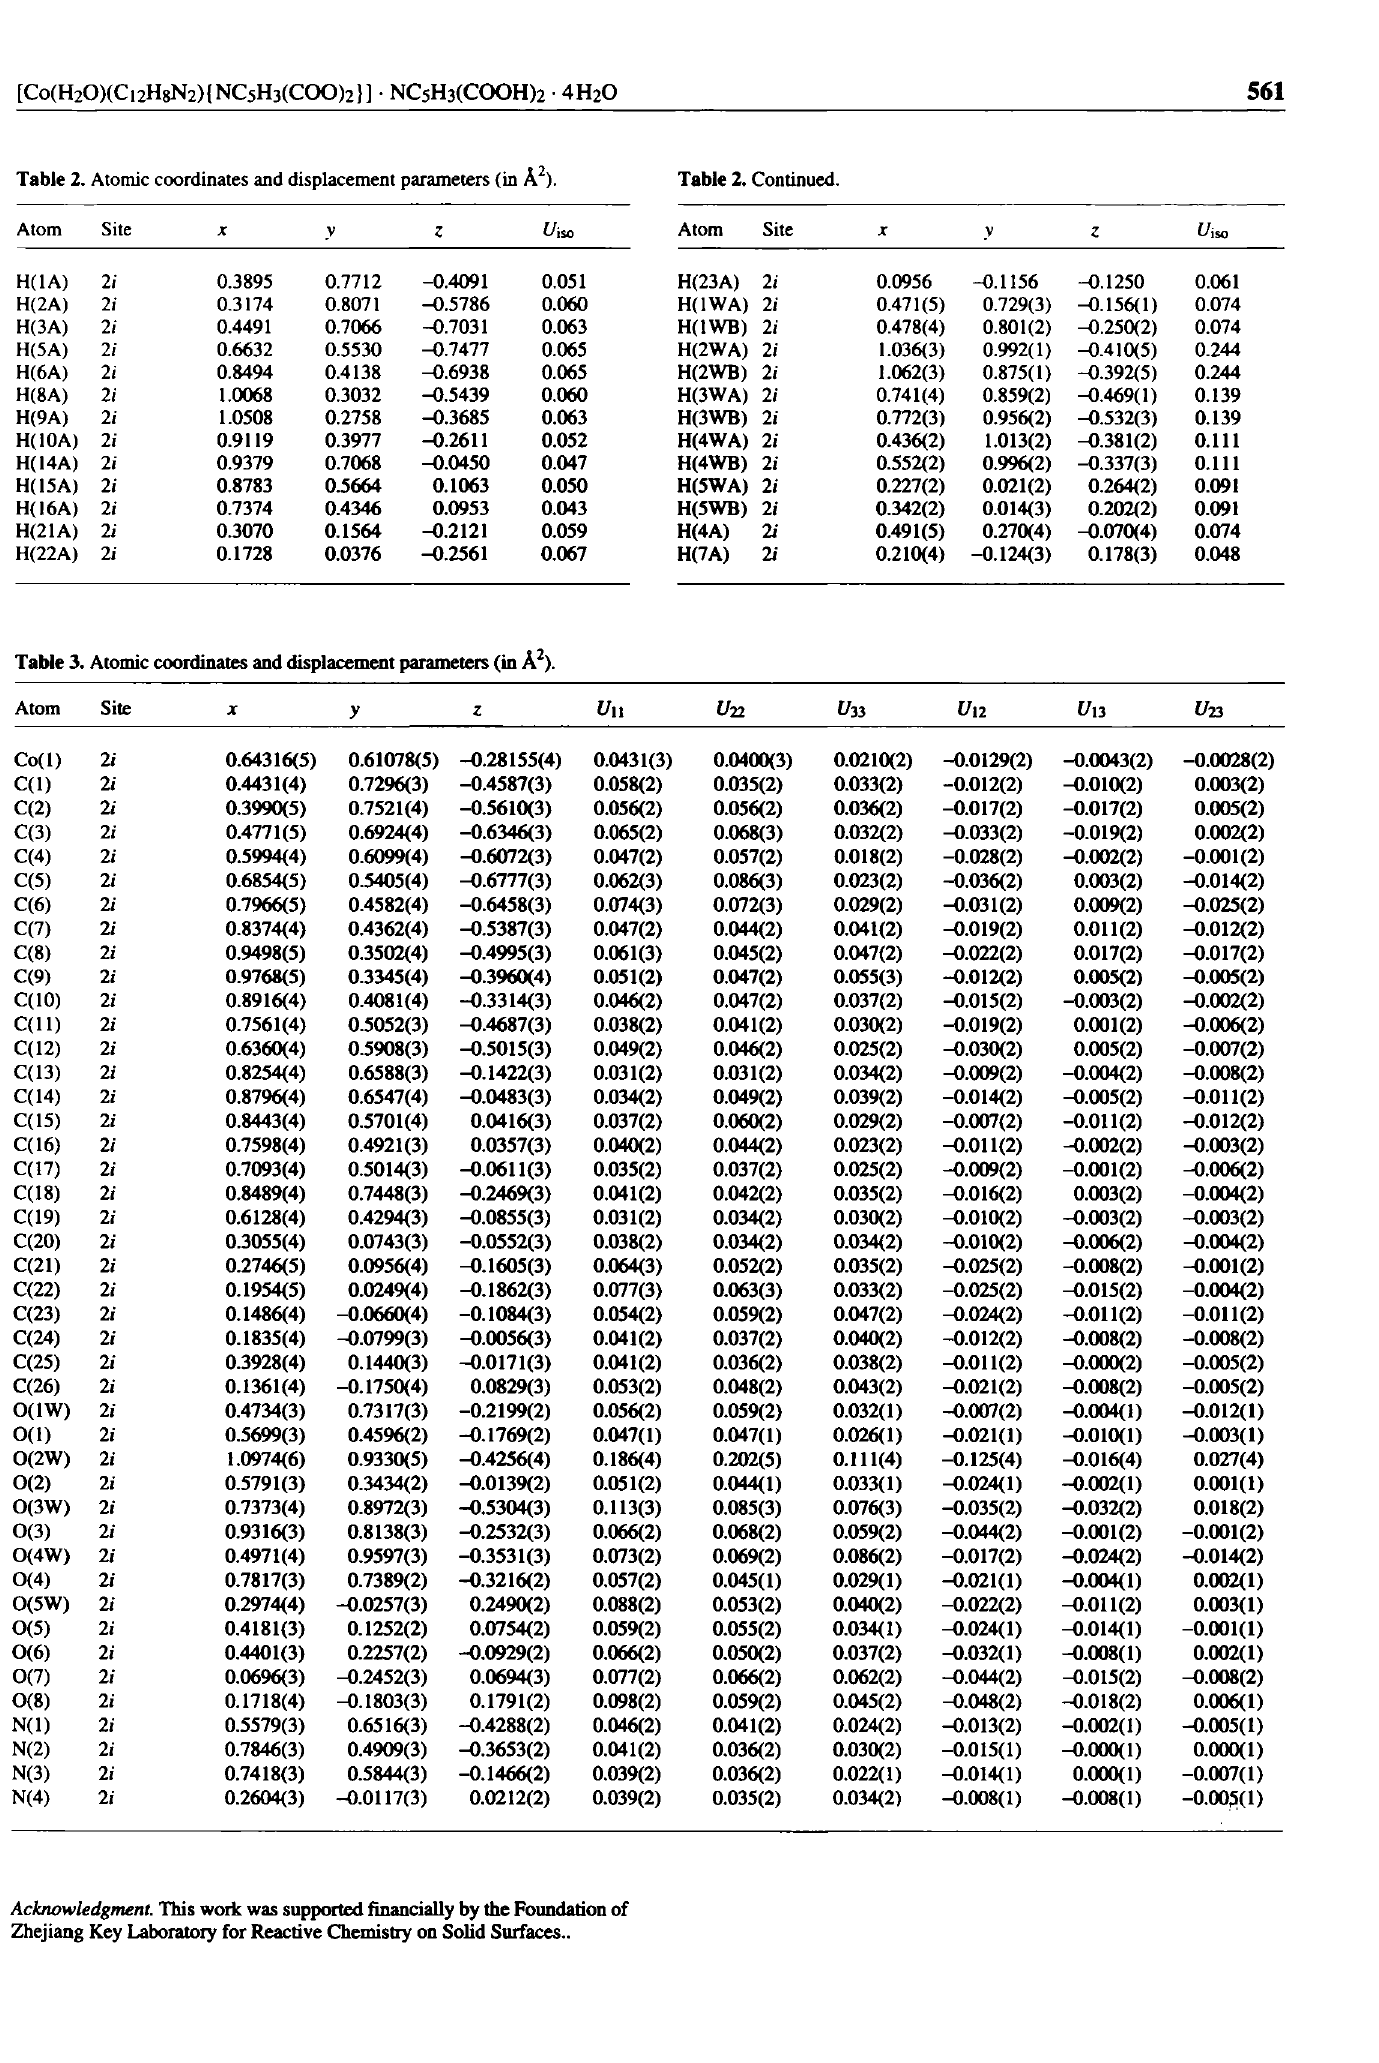
Table 3. Atomic coordinates and displacement parameters (in A 2